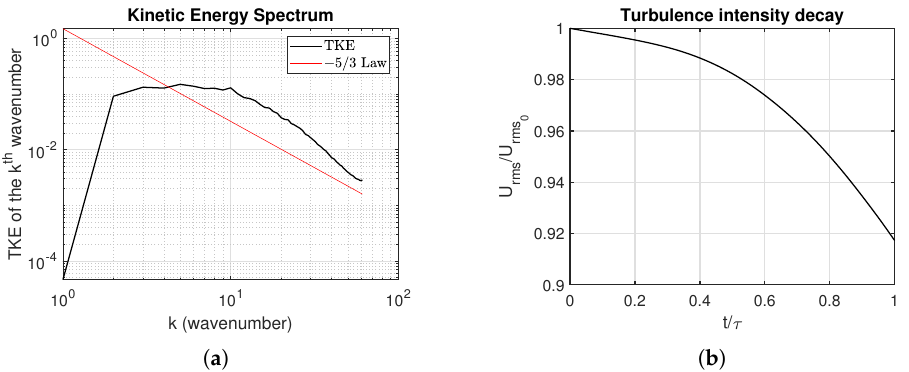
Figure 1. Characteristics of the initial turbulent field. ( a ) Turbulent energy spectrum of a sample turbulence field. ( b ) Decay of turbulence intensity. The rms velocity has been non-dimensionalised with initial rms velocity and the time has been non-dimensionalised with τ , the eddy turnover